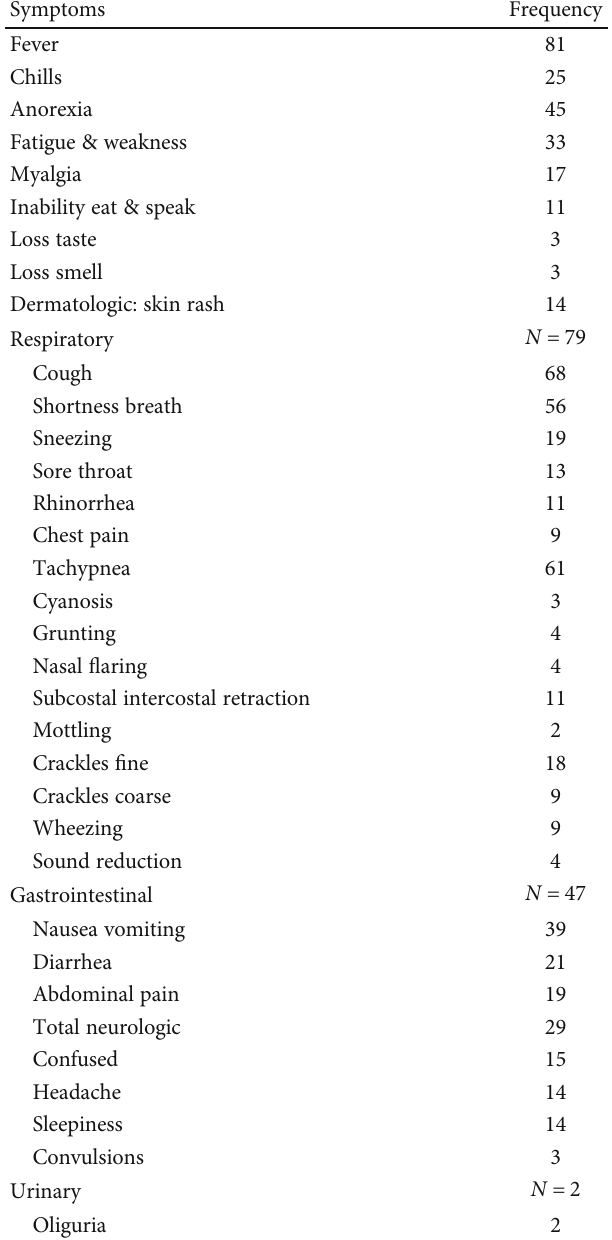
Table 4: The primary symptoms of the children admitted with COVID-19